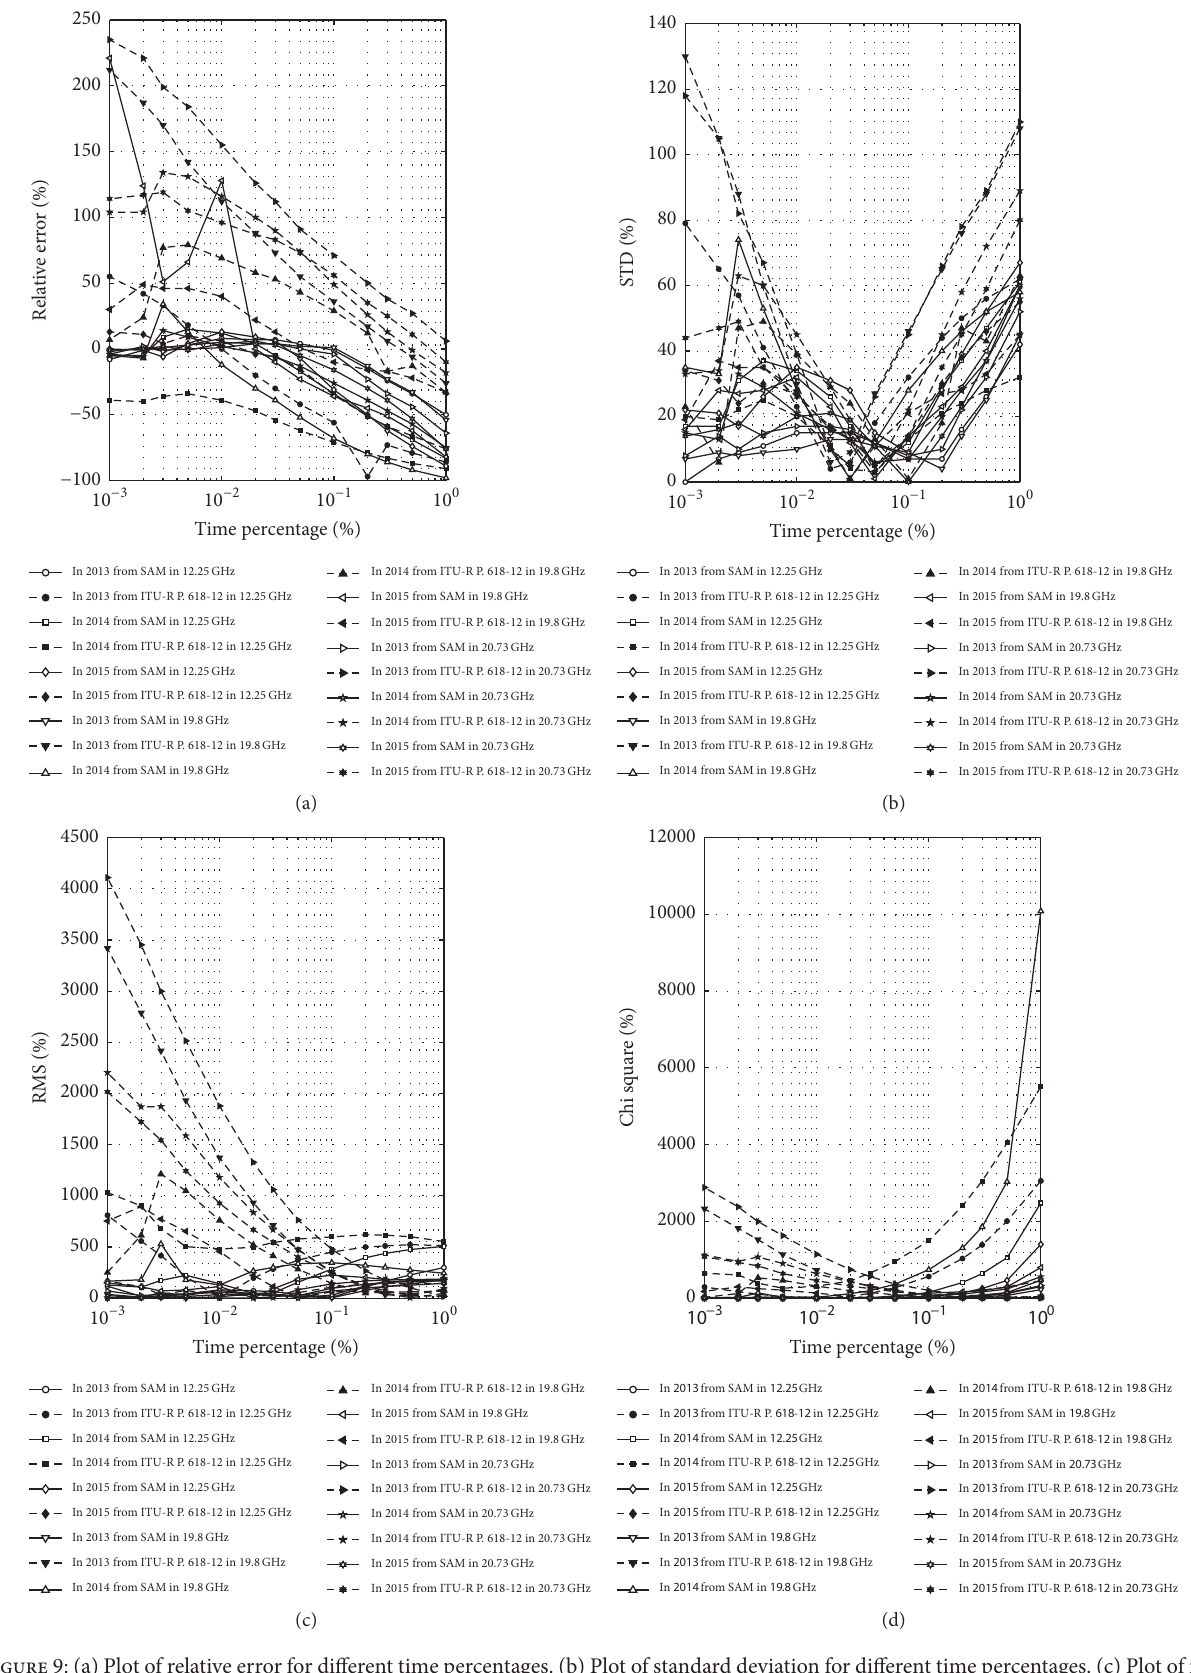
Figure 9: (a) Plot of relative error for different time percentages. (b) Plot of standard deviation for different time percentages. (c) Plot of root mean square for different time percentages. (d) Plot of chi square for different time